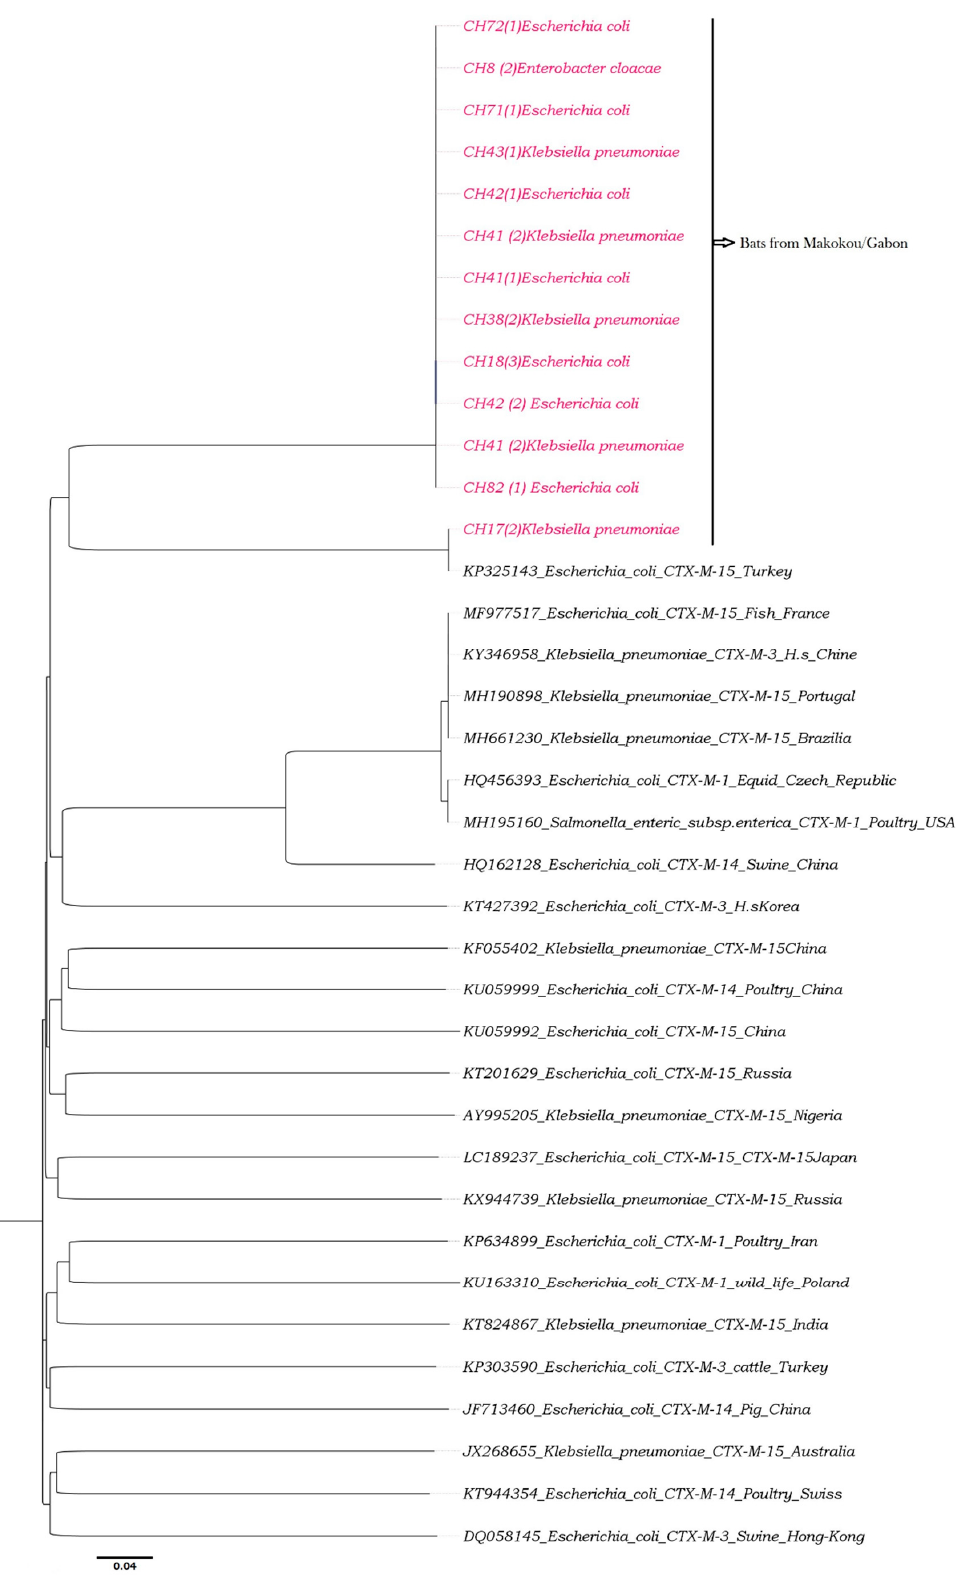
Figure 1. Phylogeny of CTX-M-15 from bats.